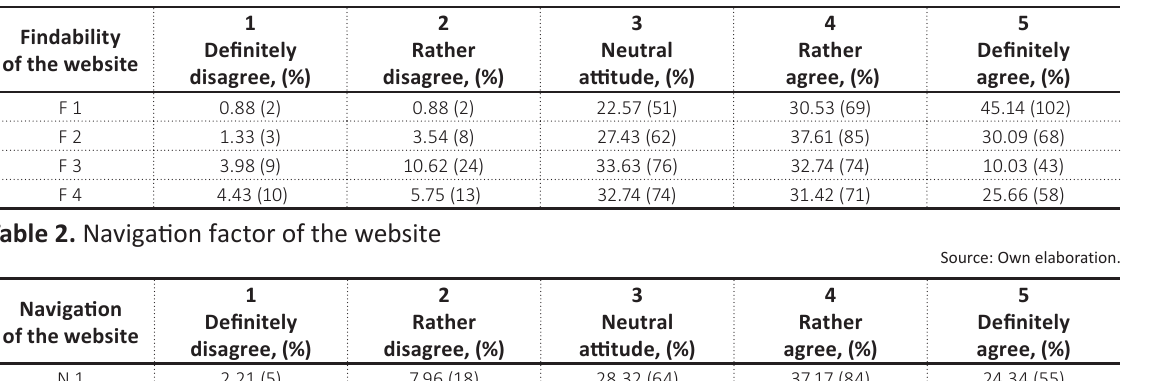
Source: Own elaboration.